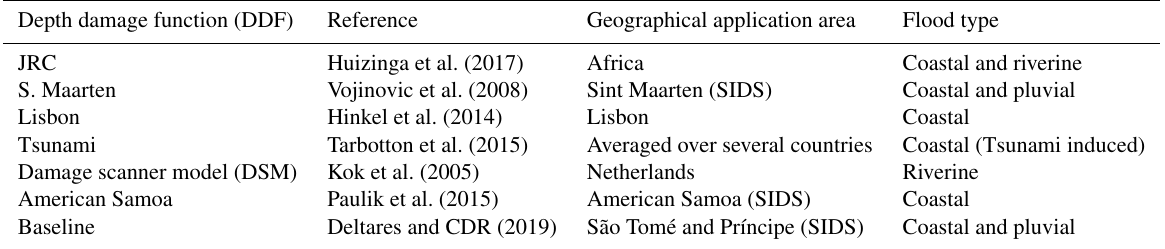
Table 4. Overview of the considered depth damage functions (DDFs), their geographical application area and flood type. Different DDF curves are shown in Fig. 4.